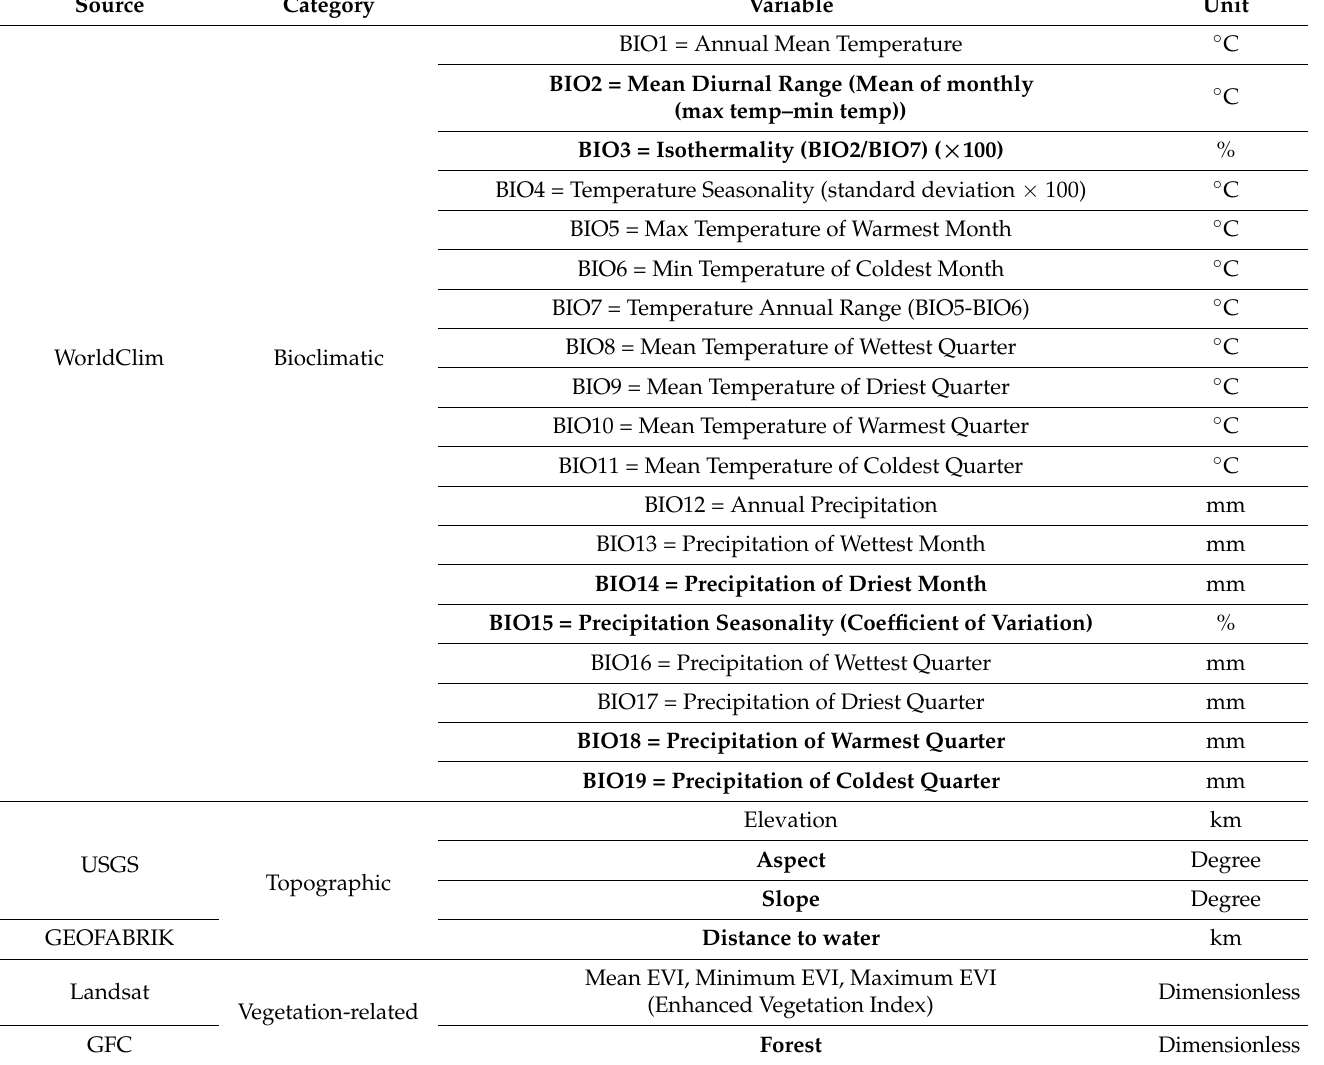
Table 1. A complete list of environmental variables compiled for this study. Environmental variables used for habitat suitability modeling for the Blue bull in Nepal are indicated by bold